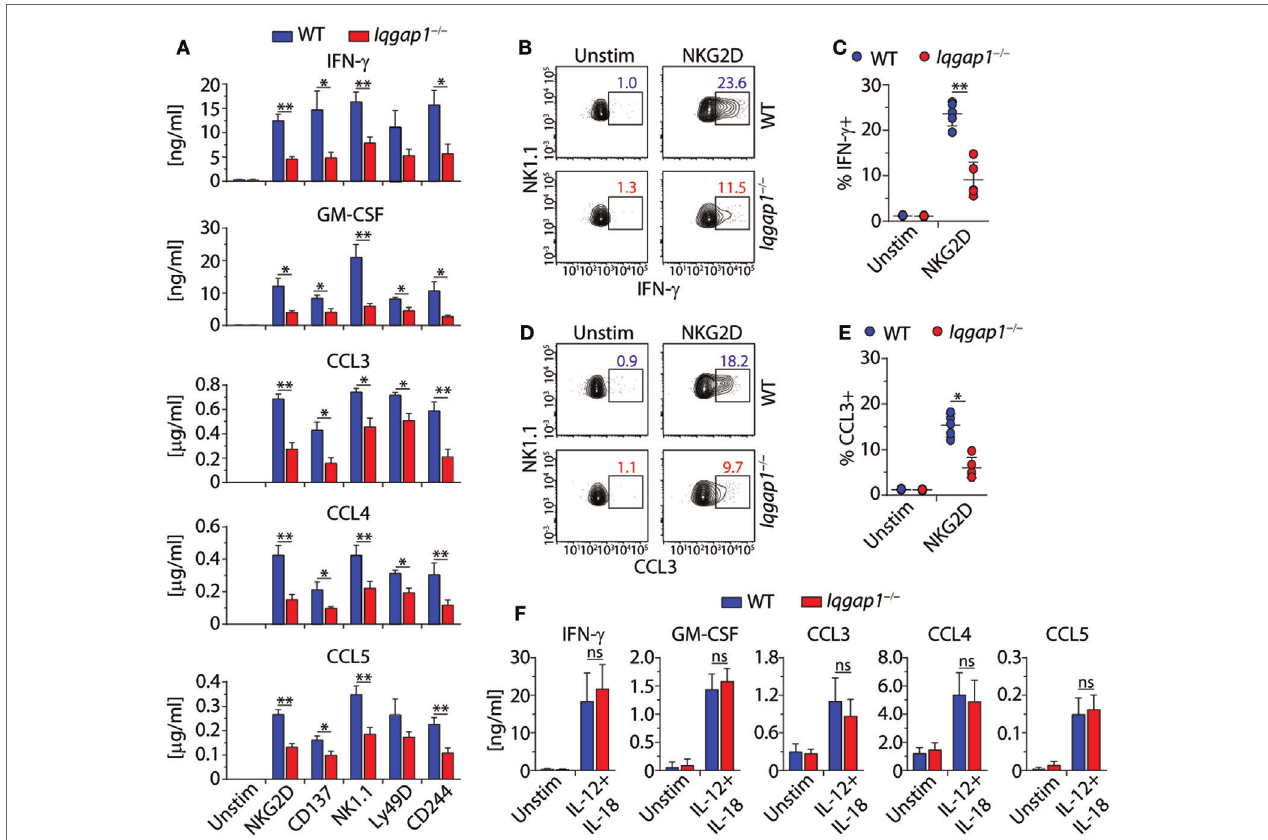
FigUre 5 | IQ domain-containing GTPase-activating protein 1 (IQGAP1) regulates inflammatory cytokine production in natural killer (NK) cells. (a) Cytokine (IFN- γ and GM-CSF) and chemokine (CCL3, CCL4, and CCL5) production by wild-type (WT) and Iqgap1 − / − NK cells were assessed 18–21 h post-NKR stimulation (2 µg/ml) by BioPlex mouse cytokine assay. (B,c) Intracellular IFN- γ and (D,e) CCL3 accumulation was evaluated by flow cytometry 12-h post-NKG2D stimulation (2 µg/ml), and the data are quantified as percent positive NK cells (CD3 ε − NK1.1 + ). (F) Cytokine and chemokine production by WT and Iqgap1 − / − NK cells was assessed 18–21 after the addition of IL-12 (1 ng/ml) and IL-18 (10 ng/ml) by BioPlex mouse cytokine assay. Error bars represent SEM (a,F) or SD (c,e) using five to eight mice in at least two independent experiments, * p < 0.05 and ** p < 0.01 using two-tailed Student’s t -test (c,e) or two-way ANOVA (a,F) accounting for multiple